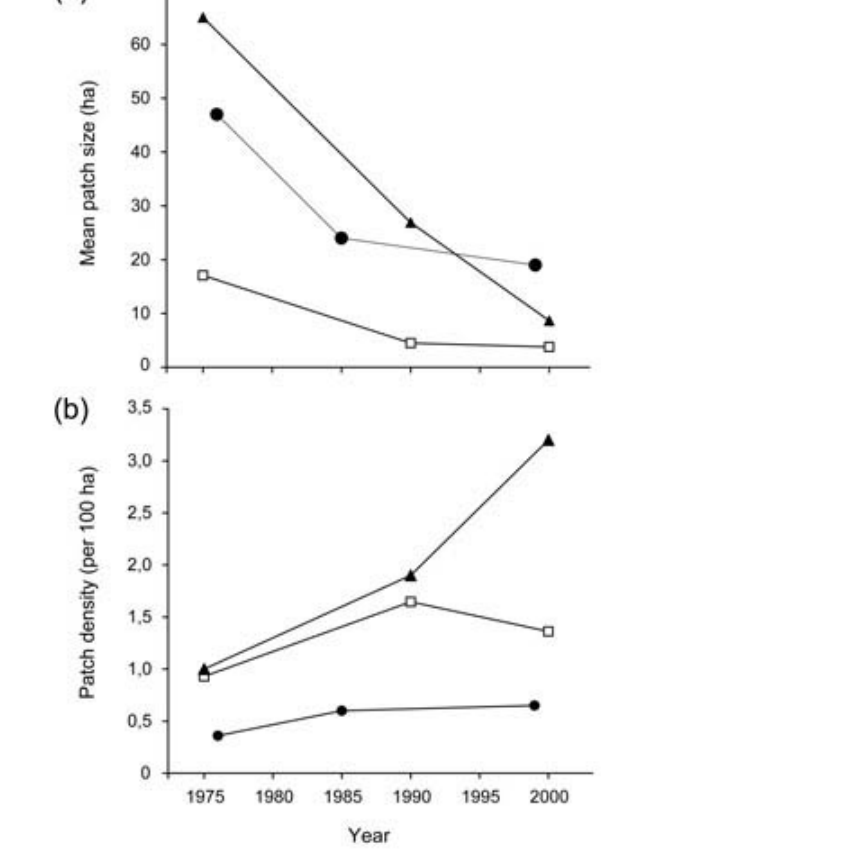
Fig. 4. Forest fragmentation in three study areas, estimated from analysis of satellite remote-sensing imagery. Two measures of fragmentation are presented: (a) mean patch size, (b) patch density. Symbols: filled circle, Los Muermos; filled triangle, Chiapas; empty square, Maule. Values were also obtained for Central Veracruz (not illustrated) for two dates, where mean patch size declined from 1176 ha in 1984 to 1291 ha in 2000, and patch density declined from 0.013 to 0.009 over the same